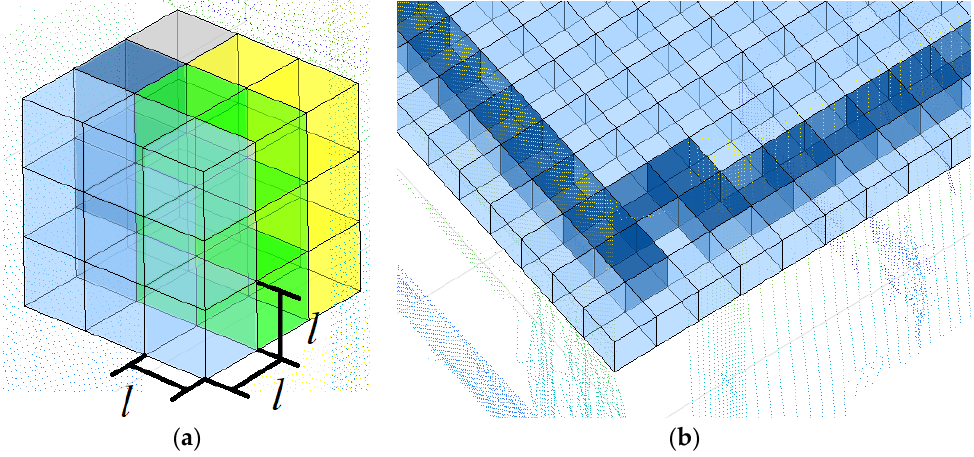
Figure 3. ( a ) Labelled voxels in a point cloud: green: recognized door; dark blue: occupied voxel; light blue: empty voxel; yellow: out voxel; ( b ) Horizontal plane of voxels: occupied voxels (dark blue) and empty voxels (light blue).